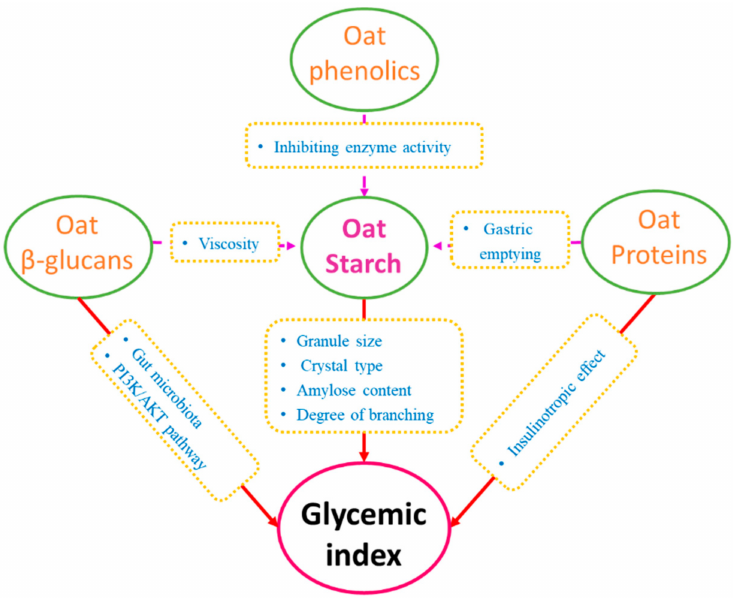
Figure 2. Schematic diagram of representative oat components that can influence